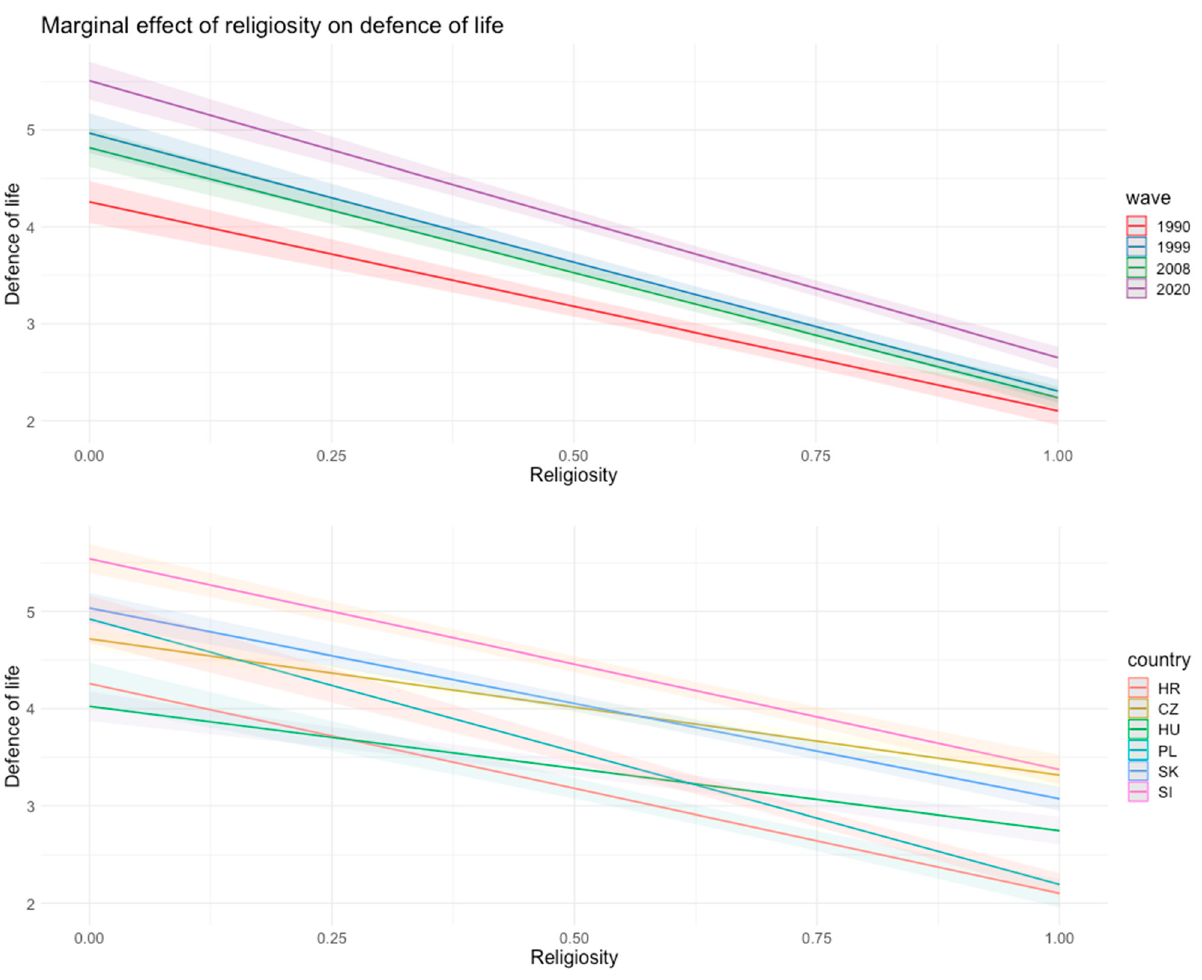
Figure 5. Predicted marginal means of defence of life per waves and countries on different level of religiosity. A more detailed regression table with the interaction effects is available in the Supplementary Materials.